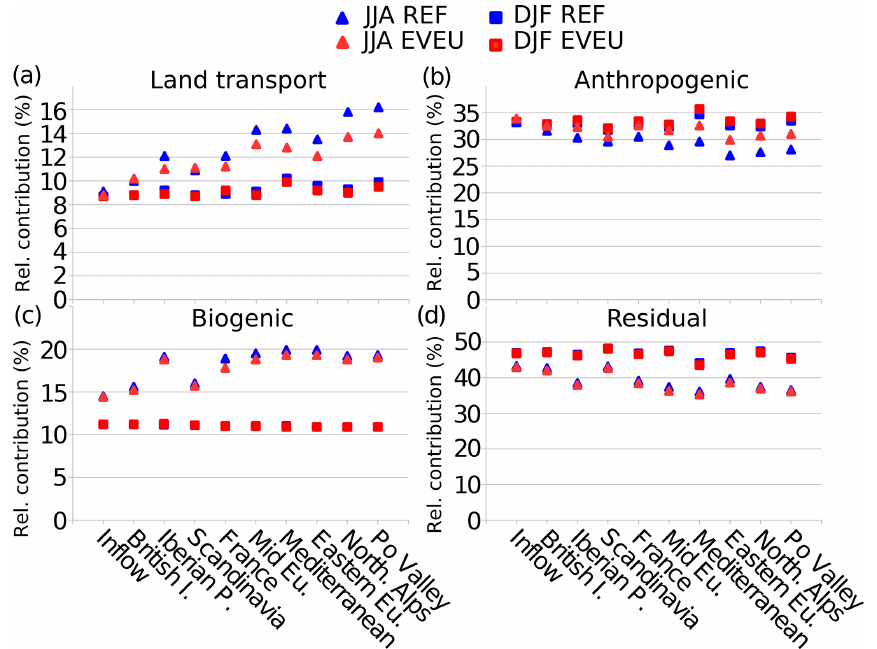
Figure 8. Area-averaged relative contributions to ground-level ozone (in percent) in different geographical regions for DJF 2008 to 2010 (triangles) and JJA 2008 to 2010 (squares). Shown are the results of the REF (blue) and the EVEU simulations (red) for (a) the land transport category, (b) the anthropogenic emissions, (c) the biogenic category, and (d) all other categories. For simplicity, the anthropogenic category contains the anthropogenic non-traffic, aviation, and shipping categories. The residual contains all other categories. The vertical-axis scale differs from (a) to (d)